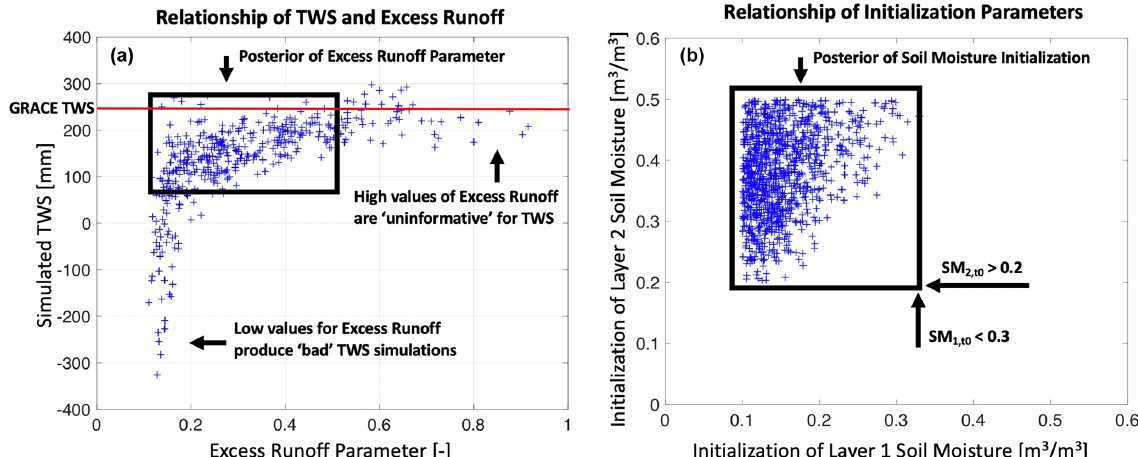
Figure 8. (a) Posterior relationship of the model-simulated TWS [mm] during April 2003 and the runoff excess parameter [unitless]. The region inside the black box indicates the posterior region with high density, i.e., plausible solutions with high likelihood. The red line shows the “true” TWS value seen in the GRACE data for this period. (b) Posterior relationship of the initialization parameters for soil moisture in layers 1 and 2, respectively. Initial SM in layer 2 is larger than 0.2[m 3 m − 3 ], initial SM in layer 1 is less than 0.3[m 3 m − 3 ], and SM 2 ,t generally larger than SM 1 ,t , as indicated in this plot. See Table 1 and Sect. 3.4 for 0